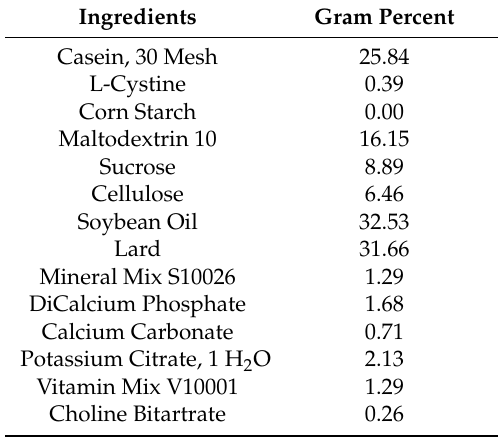
Table A1. Nutrient composition of the high fat diet, D12492 (Research Diets, Inc., New Brunswick, NJ, USA), used in the current study in combination with 20% W/W fructose in drinking water to induce a rat model of metabolic